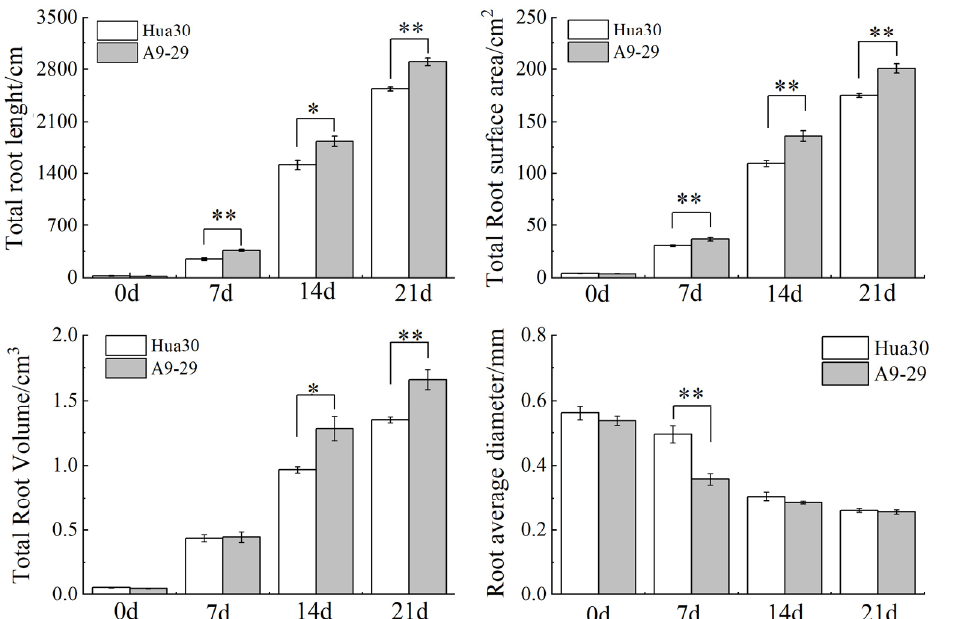
Figure 1. Effects of low-N stress on the total root length, total root surface, total root volume, and root average diameter. Values represent the mean ± standard deviation (SD) of four replicates. * or ** indicate significant differences in the pair-wise comparisons at p < 0.05 or p < 0.01.